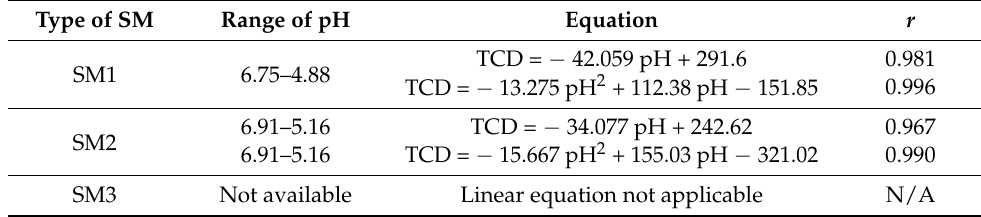
Figure 2. Colorimetric response of sensor membranes: ( a ) relationship of the total color difference (TCD) versus pH of milk samples; ( b ) corresponding images of the sensor membranes. Table 4. Equations describing the dependence of the TCD on